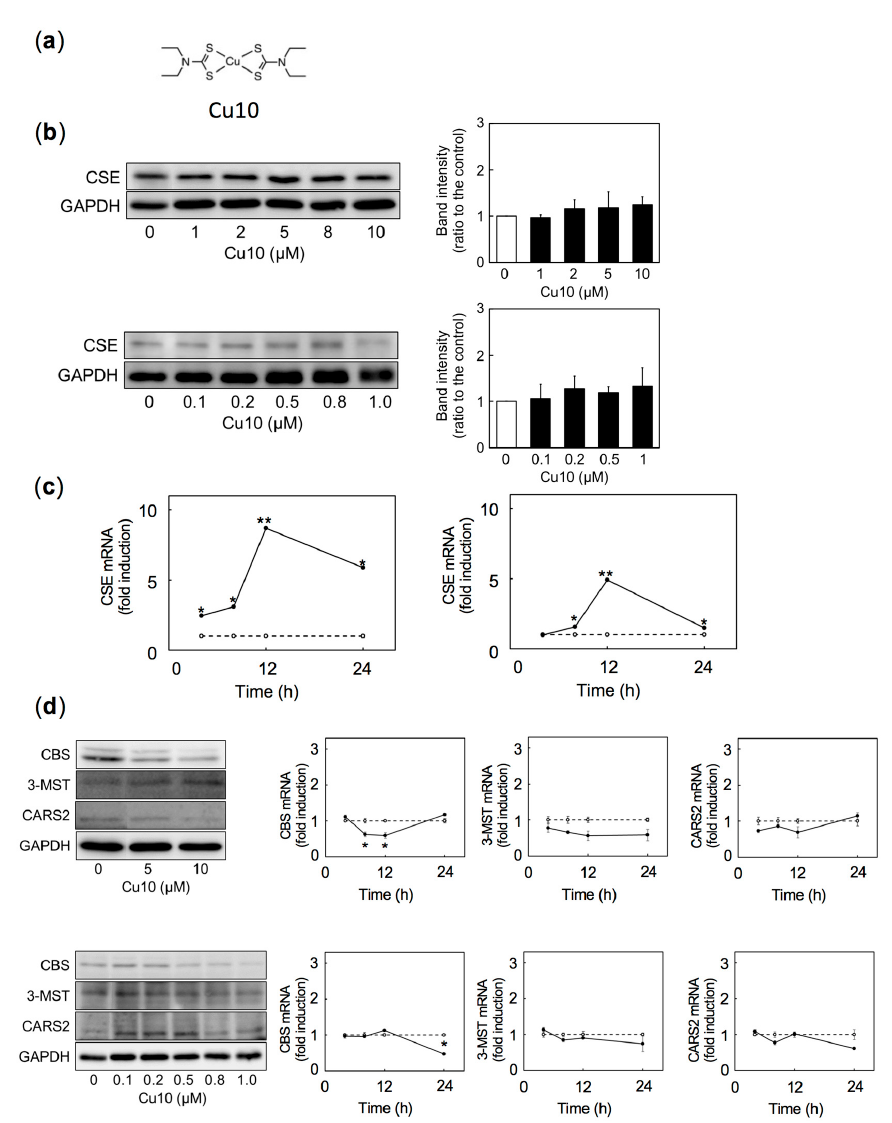
Figure 1. Expression of reactive sulfur species-producing enzymes in dense and sparse vascular endothelial cells after treatment with copper diethyldithiocarbamate (Cu10). ( a ) Structure of Cu10. ( b ) Levels of cystathionine γ -lyase (CSE) protein in dense (upper panels) and sparse (lower panels) cell cultures after treatment with Cu10. The ratio to the intensity of CSE to that of glyceraldehyde-3-phosphate dehydrogenase (GAPDH); values are mean ± SE of three replicates from three independent experiments. ( c ) Levels of CSE mRNA in dense (left panel) and sparse (right panel) cell cultures after treatment with Cu10. ( d ) Levels of cystathionine β -synthase (CBS), 3-mercaptopyruvate sulfurtransferase (3-MST), and cysteinyl-tRNA synthetase (CARS2) protein (left panels) and mRNA (right panels) in dense (upper panels) and sparse (lower panels) cell cultures after treatment with Cu10. The results of the densitometric analysis are shown in Figure S1. Dense cultures of bovine aortic endothelial cells were treated with Cu10 (1, 2, 5, 8, or 10 µM) for 24 h (left panels) or with Cu10 (5 µM) for 4, 8, 12, and 24 h (right panels). ○ , Control, ● , Cu10 treatment. Values are mean ± SE of three technical replicates. Significant difference from corresponding control, * p < 0.05; ** p < 0.01. Sparse cultures of bovine aortic endothelial cells were treated with Cu10 (0.1, 0.2, 0.5, 0.8, or 1.0 µ M) for 24 h (left panels) or with Cu10 (5 µ M) for 4, 8, 12, and 24 h (right panels). , Control, • , Cu10 treatment. (cid:35) Values are mean ± SE of three technical replicates. Significant di ff erence from corresponding control, * p < 0.05; ** p <